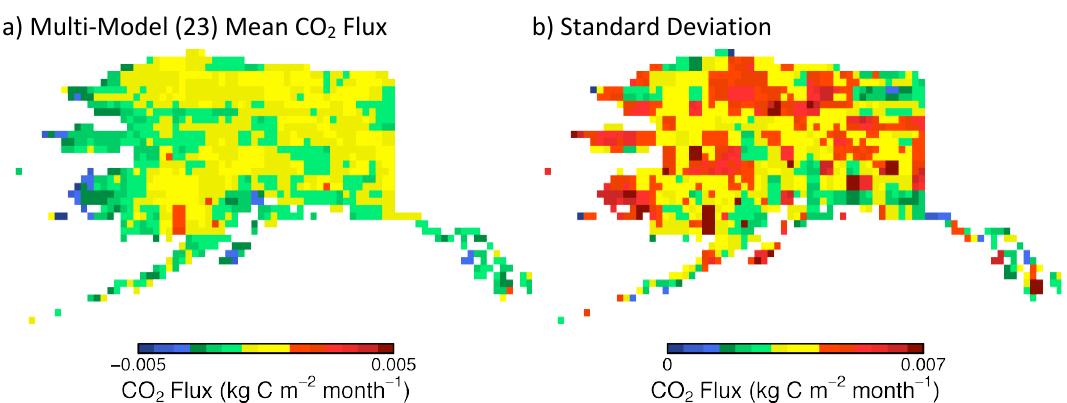
Figure 3. NACP and TRENDY multi-model ( n = 23) net CO 2 flux for 2003 (a) mean, and (b) standard deviation. 948